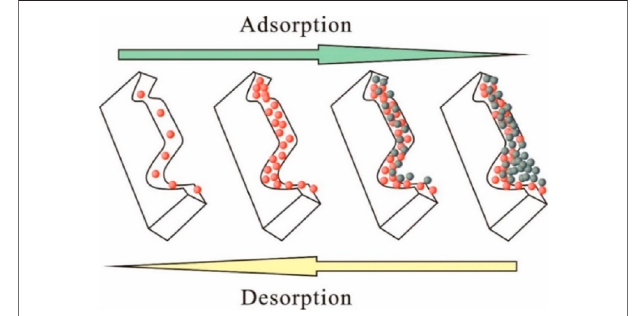
FIGURE 1 | Schematic of nitrogen adsorption/desorption (Ma,